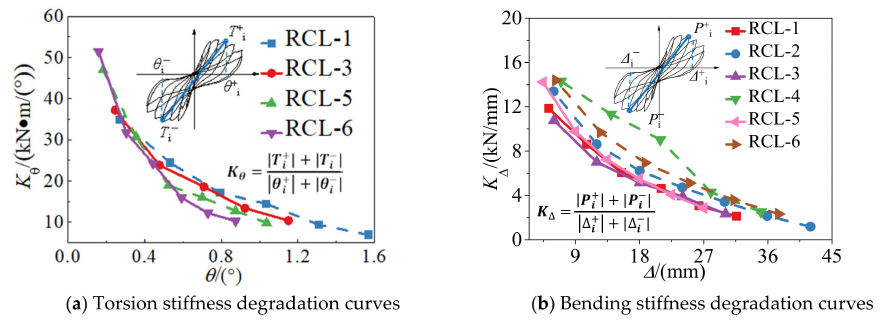
Figure 12. Sti ff ness degradation curves.